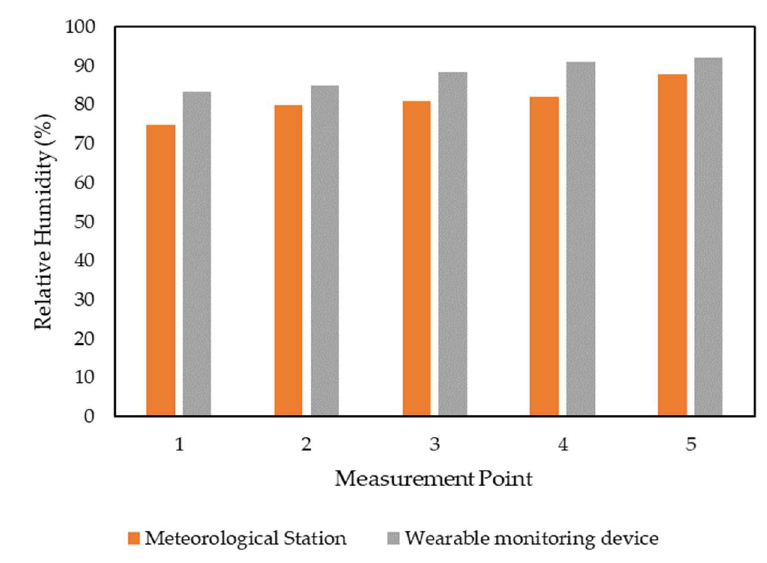
Figure 6. Relative humidity measurements comparison at points (1 to 5).